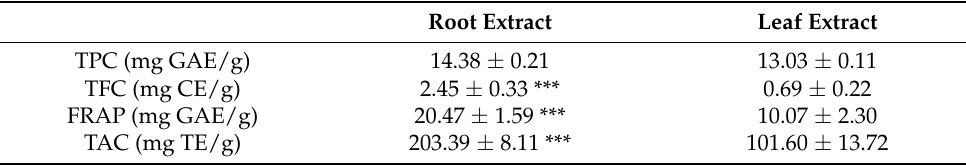
Table 1. Total phenolic and flavonoid contents and antioxidant capacities of root and leaf extracts from L. fischeri